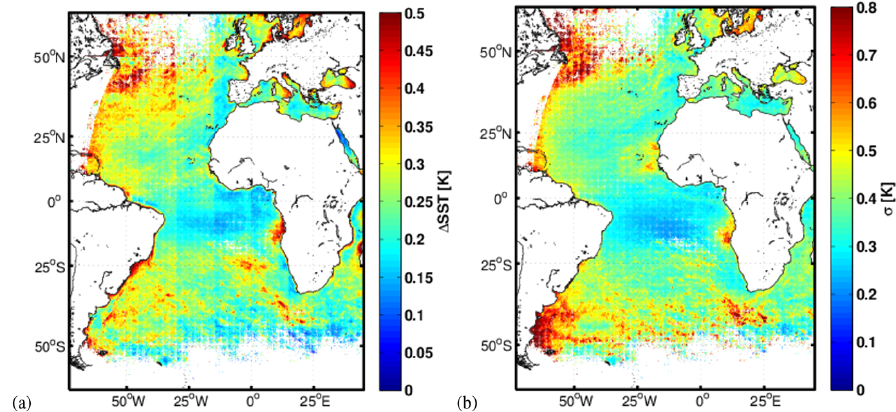
Figure 5. Spatial extent of (a) 1 SST, defined as the maximum of the monthly averaged 1 SST day , i.e. the mean SST day − SST found , where white areas indicate less than 10 1 SST day values, (b) σ of the 1 SST day during the month when 1 SST occurs.